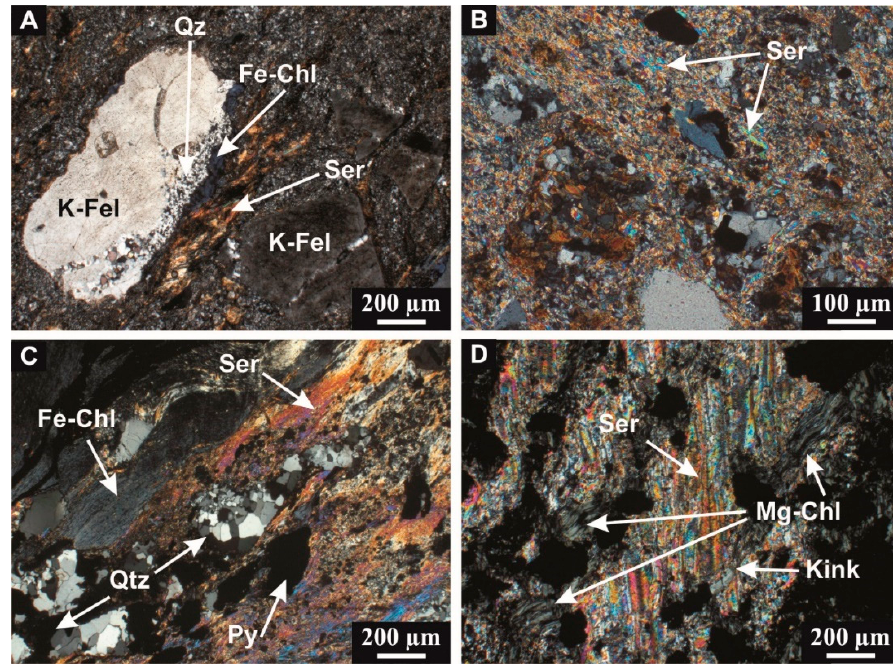
Figure 5. Photomicrographs (crossed-polarized light) of representative white mica varieties from the BMC. ( A , B ) K-feldspar phenocrysts in volcanic rocks with groundmass partially or completely are replaced by an intergrowth of sericite, chlorite, and quartz (HN-99-119 at 308 m and 95-LPA-10 at 239 m). ( C ) Sericite-rich bands or septa quartz-feldspar tuff (LPA-054 at 369 m). ( D ) Kink bands and crenulation cleavages in sericitic and chloritic bands (HN-99-119 at 1250 m).